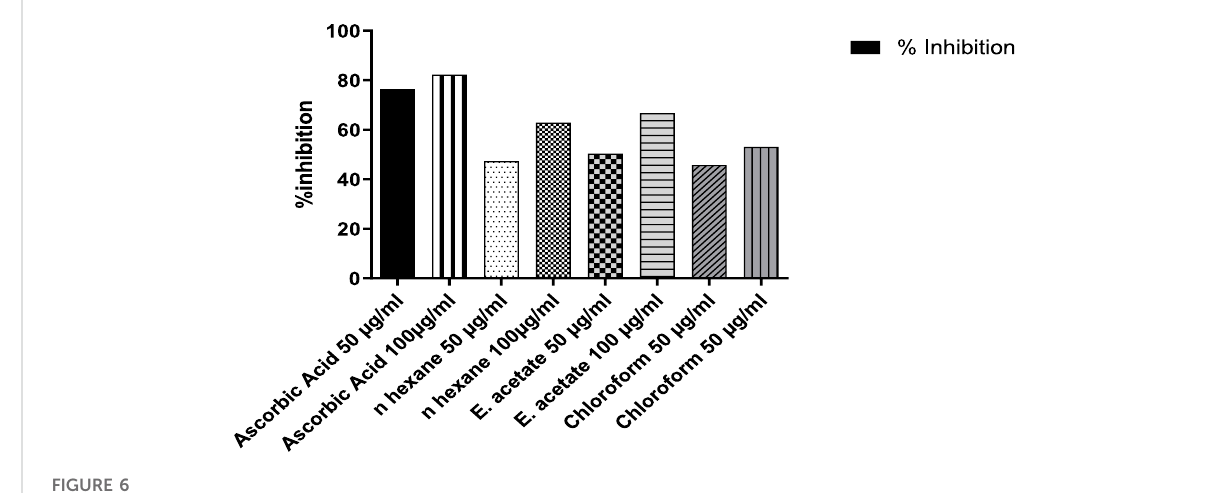
FIGURE 6 Percent inhibition of DPPH free radical-scavenging activity of Justicia adhatoda at different concentrations.